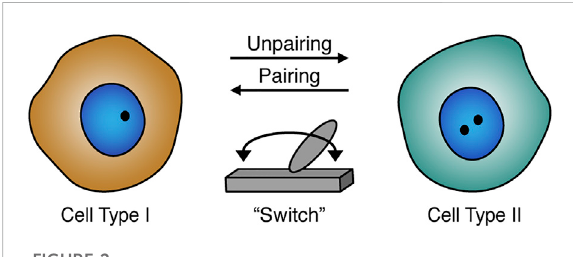
FIGURE 2 Homolog pairing role during development and differentiation. Homolog pairing levels may act as a potential “ switch ” (gray) that could play a role in cell type-speci fi c gene regulation. The pairing status can also be related to cell differentiation including the formation or maintenance of cellular identities. Schematic of paired (one black dot) or unpaired (two black dots) homologs in the nucleus